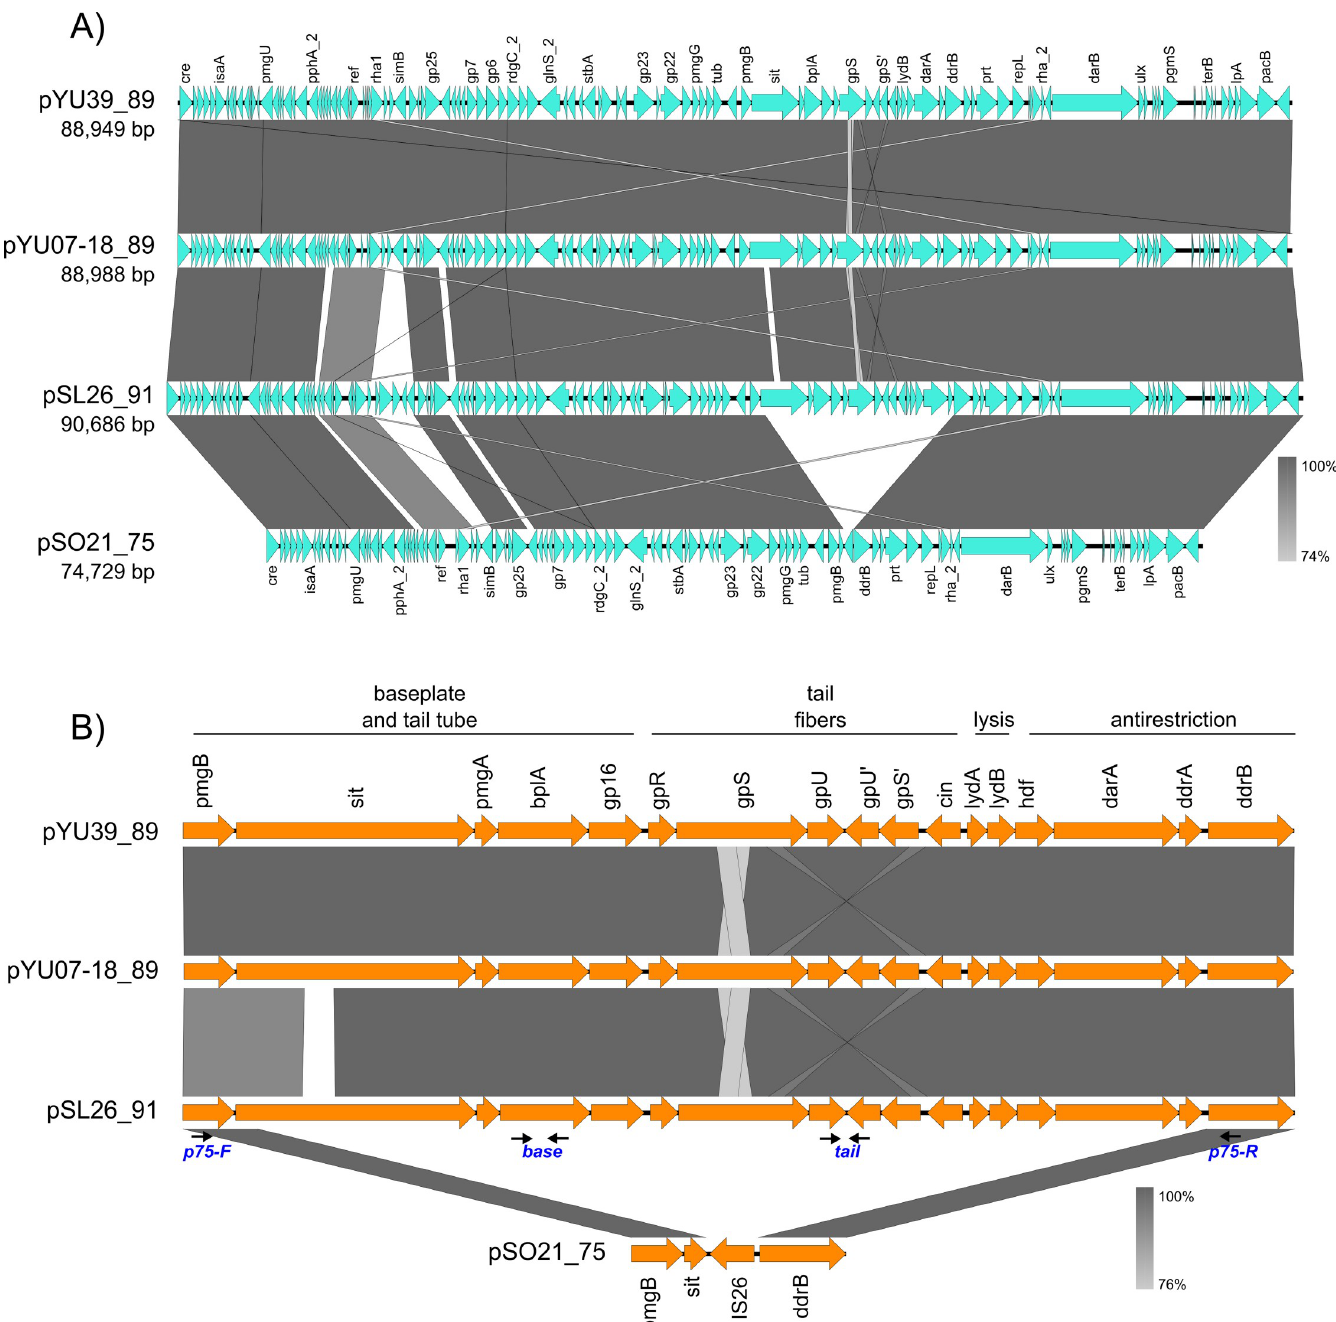
Fig 3. Comparison of the D6-like plasmid prophages from four Typhimurium ST213 strains. A) The sequences of D6-like prophages were extracted from the complete genomes of strains YU39, YU07-18, SL26 and SO21. The accession numbers for pYU39_89, pYU07-18_89, pSL26_91 and pSO21_75 are CP011430, CP035549, CP032492 and CP032497, respectively. B ) Detail of the variable region between complete and incomplete D6-like prophage variants. The primers for the three regions ( base , for baseplate gene bplA ; tail , for tail fibers gene gpU-gpU’ ; and p75 , flanking the incomplete region) used to distinguish the variants are indicated in blue below two thin arrows. The scale shows the sequence (nucleotide) identity